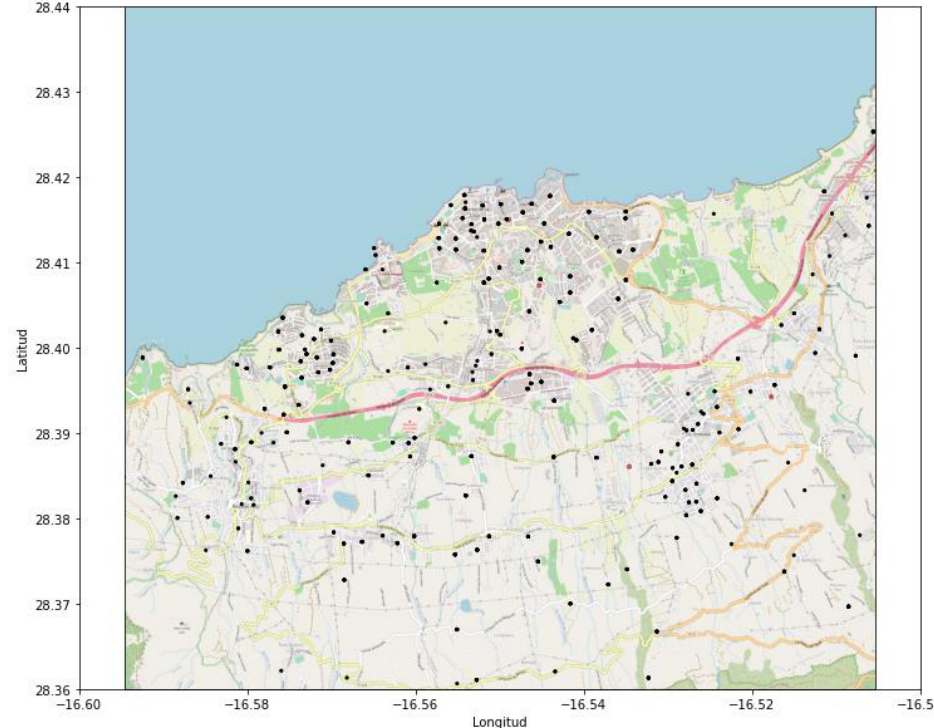
Figure 19. Distribution of charging points in La Orotava Valley with each black dot representing a charging point.